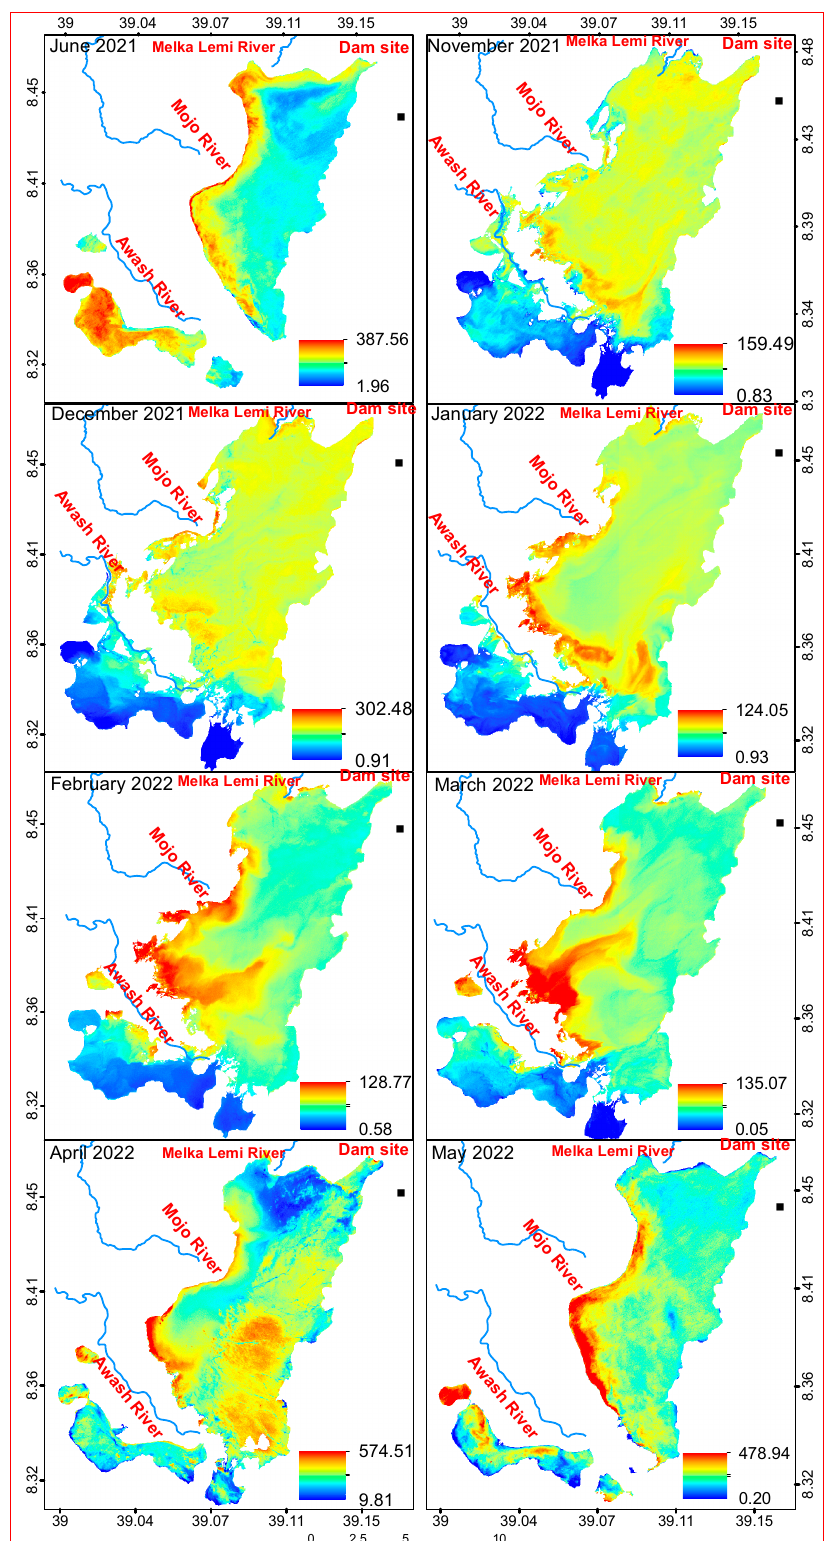
Figure A2. Monthly TSS (in mg/L) spatial distribution.